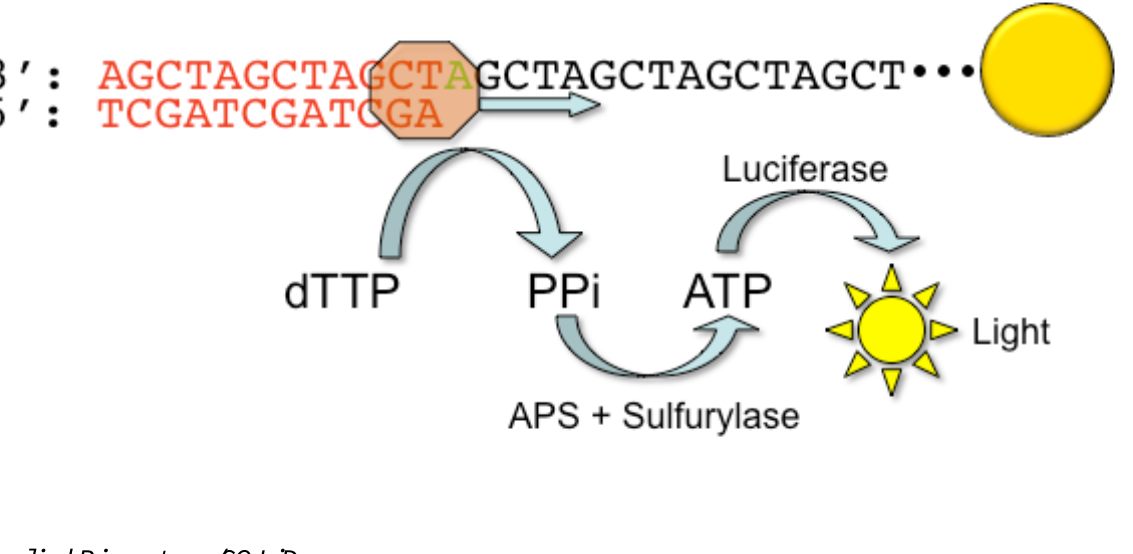
Figure 2. Pyrosequencing chemistry. DNA templates linked to a capture bead (yellow) are exposed to only one nucleotide during each round of sequencing. As a nucleotide (dTTP in this example) is incorporated through the action of DNA polymerase (brown), inorganic pyrophosphate (PPi) is released which reacts with adenosine 5’-phosphosulfate (APS) and sulfurylase to generate ATP. ATP is then used as a substrate for luciferase to generate light, which can be detected and